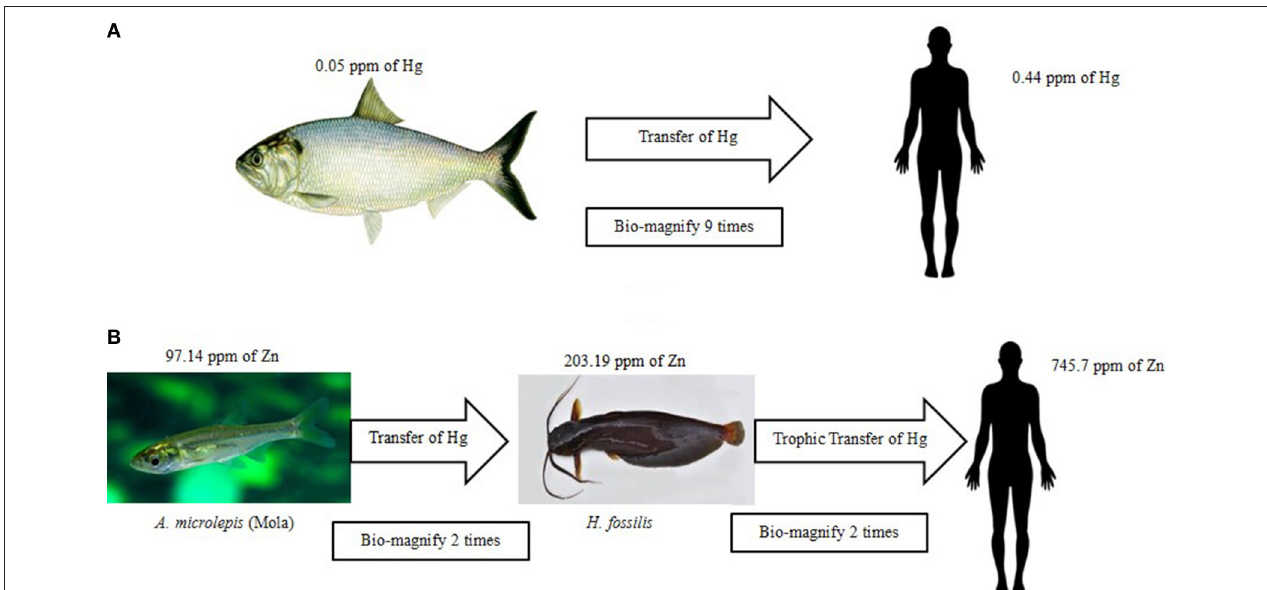
FIGURE 3 | Bio-magnification of (A) Hg and (B) Zn at different trophic